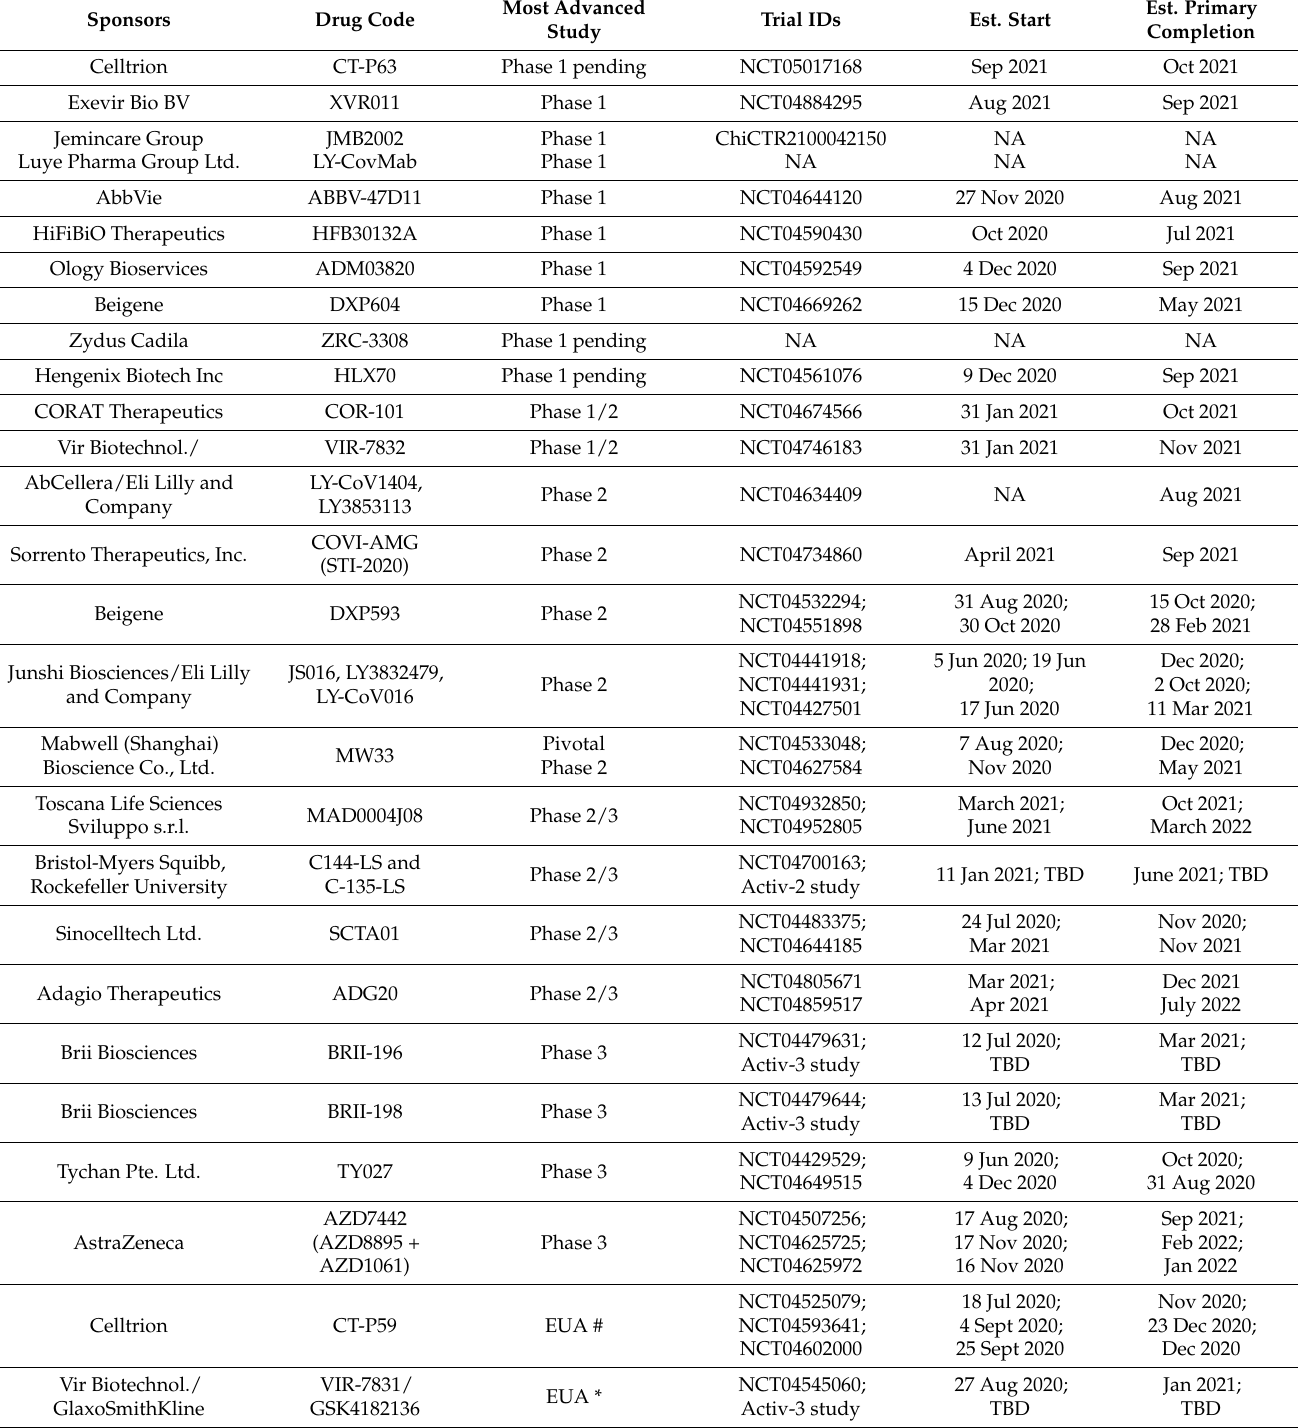
Table 1. Anti-SARS-CoV-2 mAbs in clinical